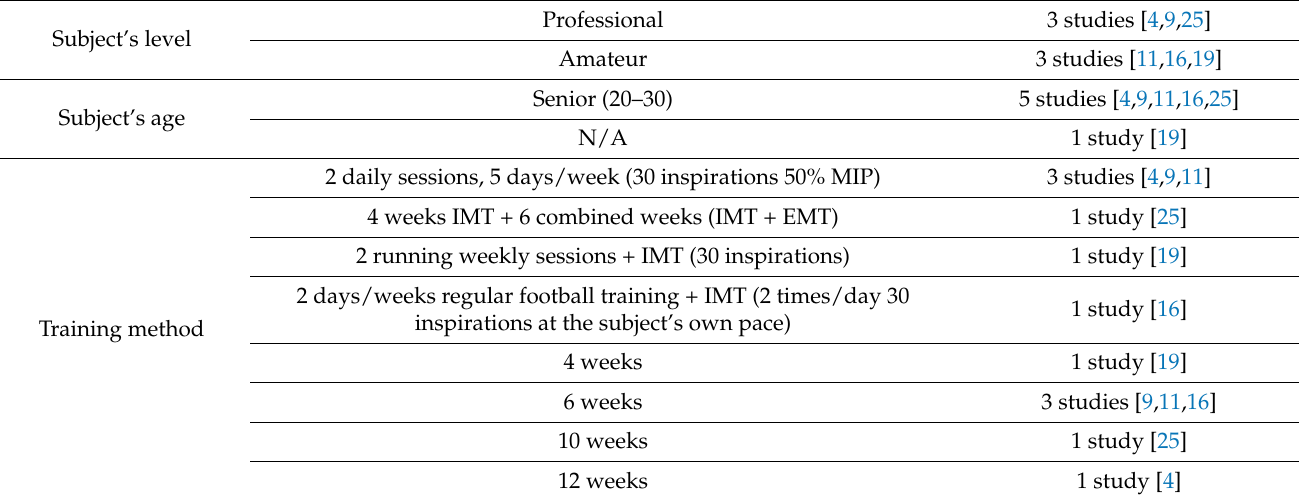
Table 1. Descriptive synthesis of the studies included in the systematic